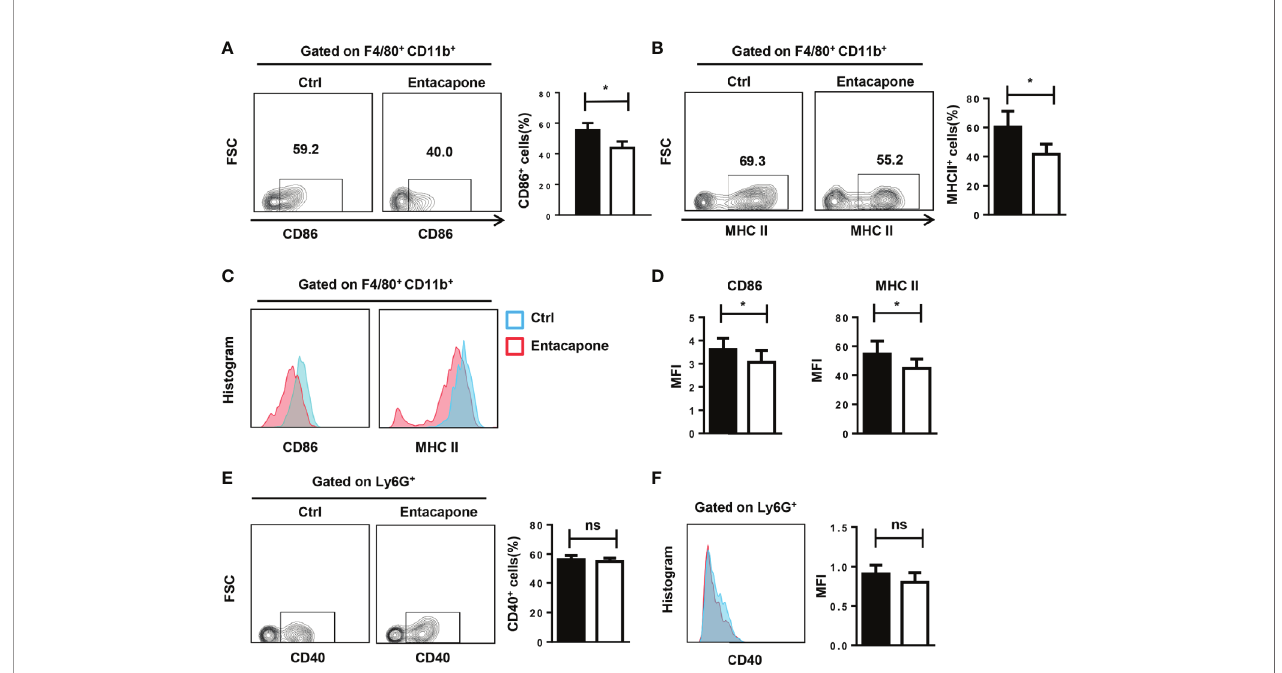
FIGURE 7 | Entacapone treatment attenuates macrophage activation in LPS-induced septic shock. C57BL/6 mice were pre-treated with or without entacapone (10 mg/kg) 2 days prior to LPS injection and 1 h before LPS treatment (15 mg/kg). The peritoneal cells (A, B , E) and splenocytes (C, D , F) were harvested 6 h after intraperitoneal injection of LPS. (A – D) Representative fl ow cytometry data for analysis of CD86 and MHC II expression in macrophages, and the mean fl uorescence intensity values of CD86 and MHC II expression in F4/80 + CD11b + macrophages are shown as bar graphs (n=8 for each group). (E, F) Representative fl ow cytometry data for analysis of CD40 expression in neutrophils, and the mean fl uorescence intensity values of CD40 expression in Ly6G + neutrophils are shown as a bar graph. Data are shown as mean ± SEM; *P < 0.05 (two-tailed unpaired t-test). ns, not signi fi cant.